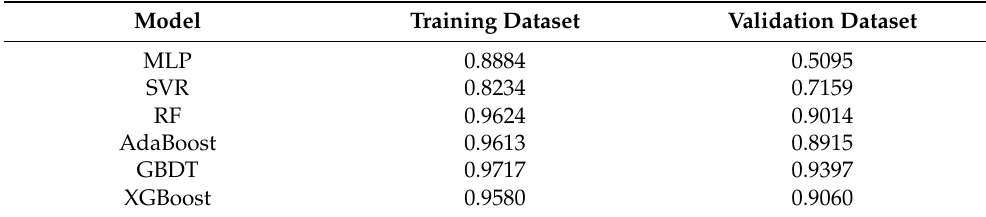
Table 8. Evaluation results of dataset splitting of the six crown profile models based on artificial intelligence